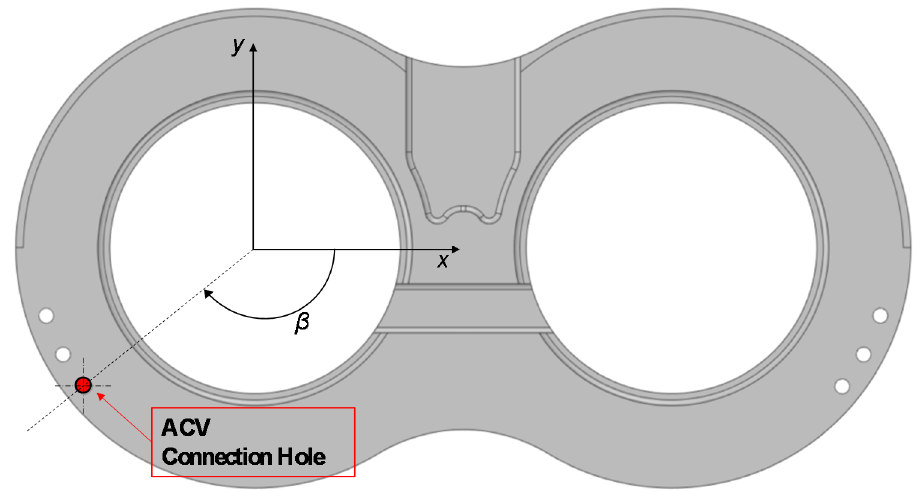
Figure 17. Definition of the Angle β .